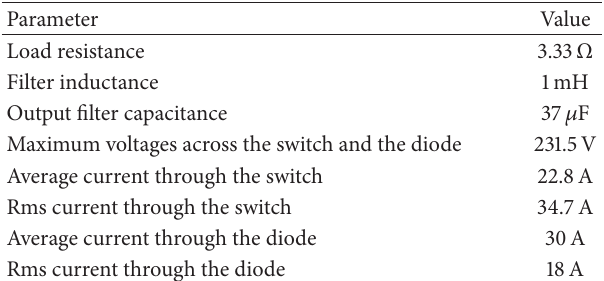
Table 4: Power stage components for the designed